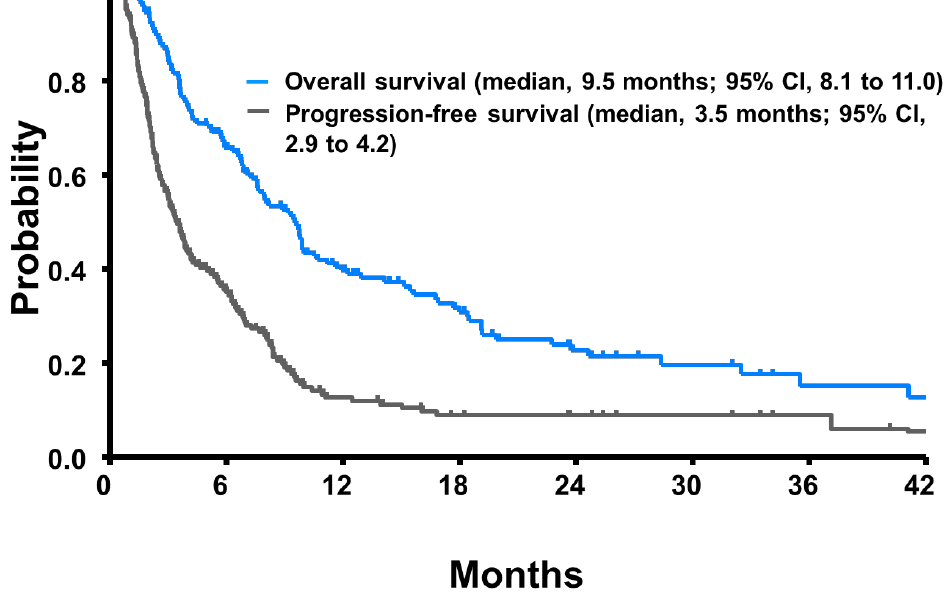
Figure 2. Progression-free survival (gray line) and overall survival (blue line) for 166 patients who were treated with third-line therapy.